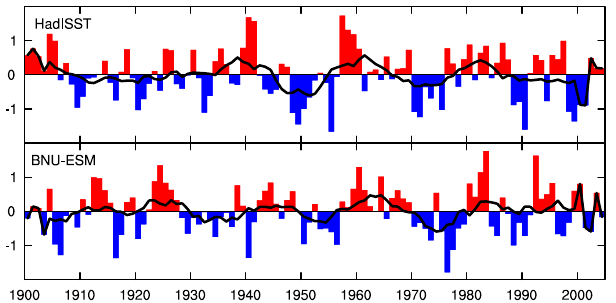
Figure 22. Time series of the normalized leading EOF mode of SST anomalies in the North Pacific domain (as Fig. 21) over the period 1900–2005 for HadISST and BNU-ESM. The solid black lines show decadal variations after 10 year running